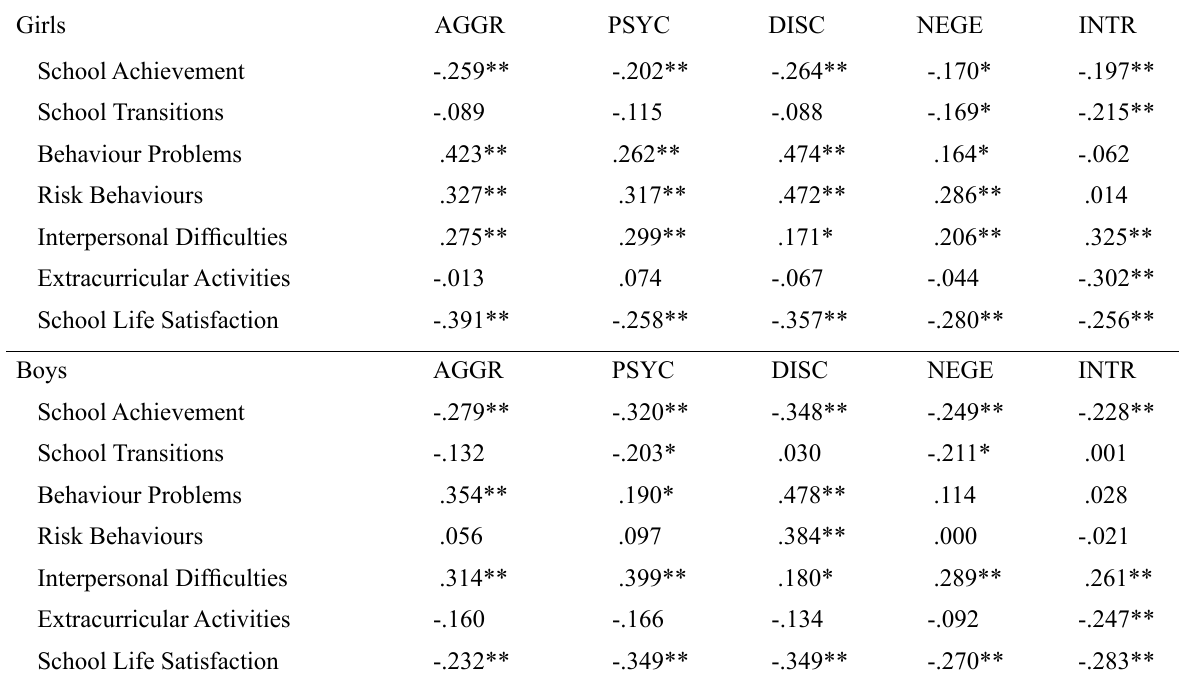
Pearson Correlation Coef fi cients between PSY-5 Dimensions and School Life Variables, for Each